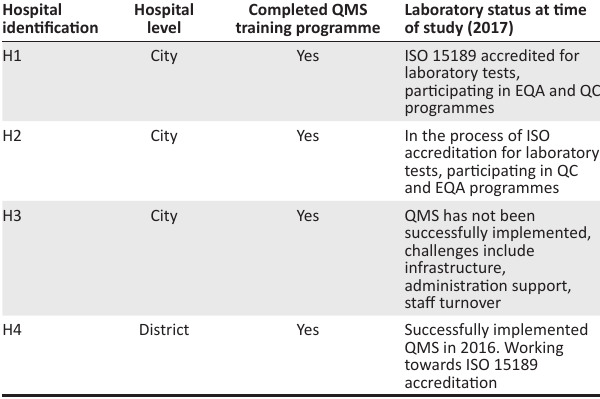
TABLE 1: Vietnamese hospitals participating in this study